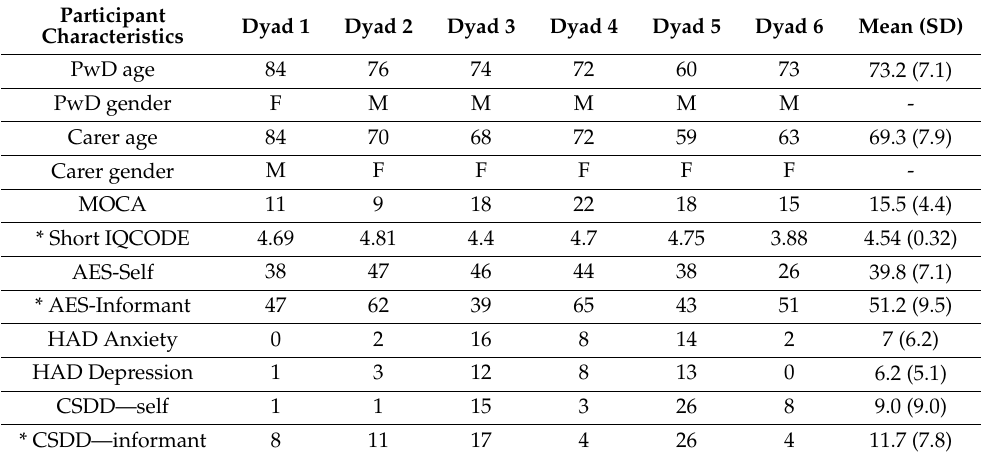
Table 1. Summary of participant demographic and clinical data.